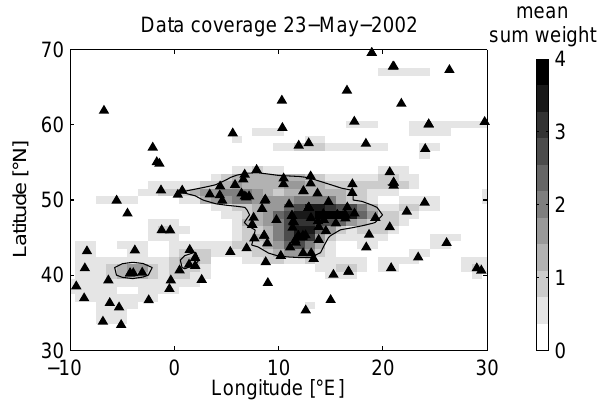
Fig. 1. Map of the average sum of all affecting weights at each grid point of the TEC perturbation map on the 23 May 2002. The black line encapsulates the areas where the summed weights are bigger than 1. The triangles indicate the position of the available GNSS ground